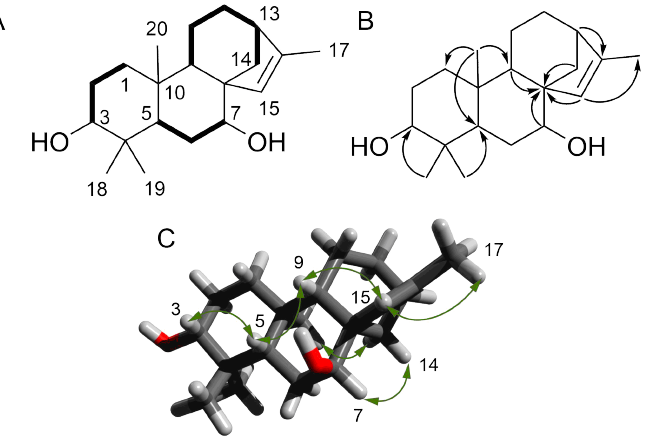
Figure 2. ( A ) COSY correlations; ( B ) HMBC key correlations; and ( C ) NOESY